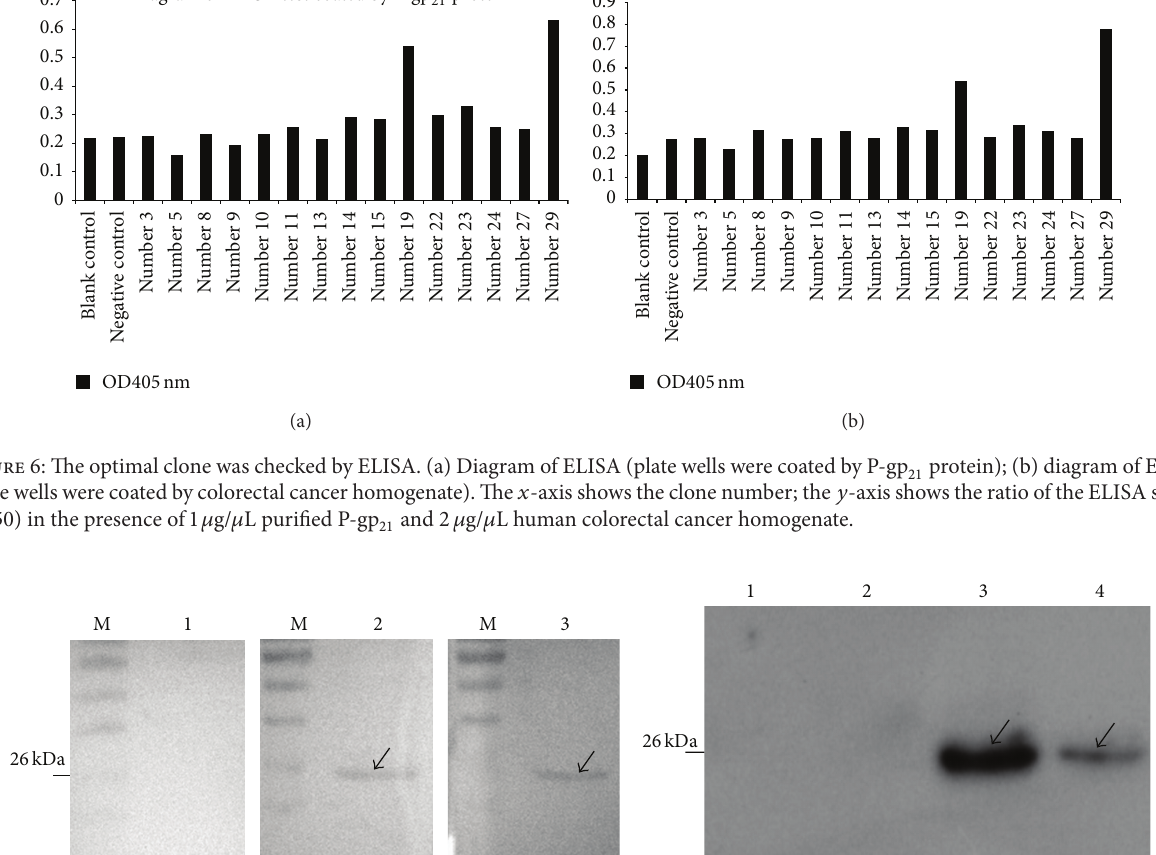
resistance. Among them, multidrug resistance (MDR) may be the major obstacle affecting the effectiveness of the